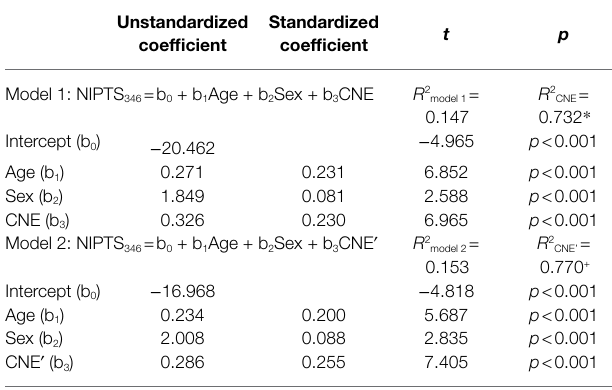
TABLE 3 | The multiple linear regression analyses between NIPTS 346 and key factors. Unstandardized Standardized coefficient coefficient